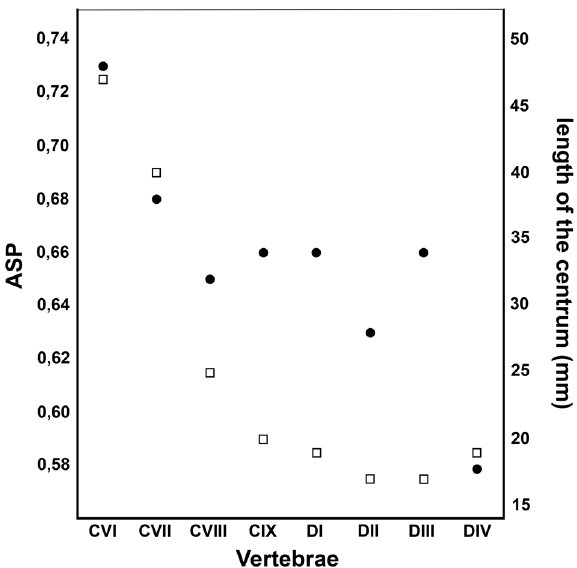
Figure 6. Relationship between pneumatisation and centrum length of the vertebrae. Mean vertebral ASP (black circles) and length of the centra (white squares) of the eight analysed vertebrae of SNSB/BSPG 1991 I 27. CVI–IX, sixth to ninth cervical vertebrae; DI–IV, first to fourth dorsal vertebrae. Mean ASP values from Table 2. Centrum length measurements from Veldmeijer et al. 29 (2009).